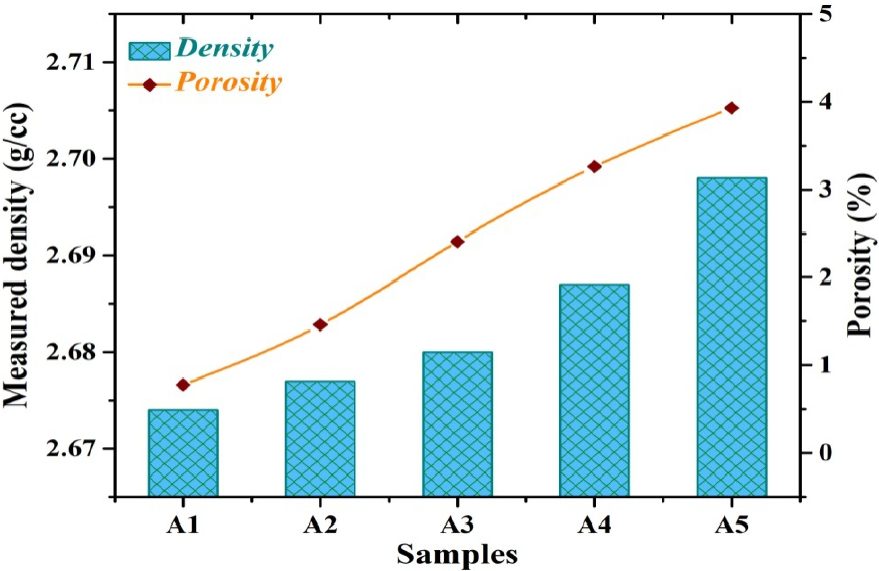
Figure 2. Density and porosity of the Al/SiC/TiO 2 hybrid nanocomposites.